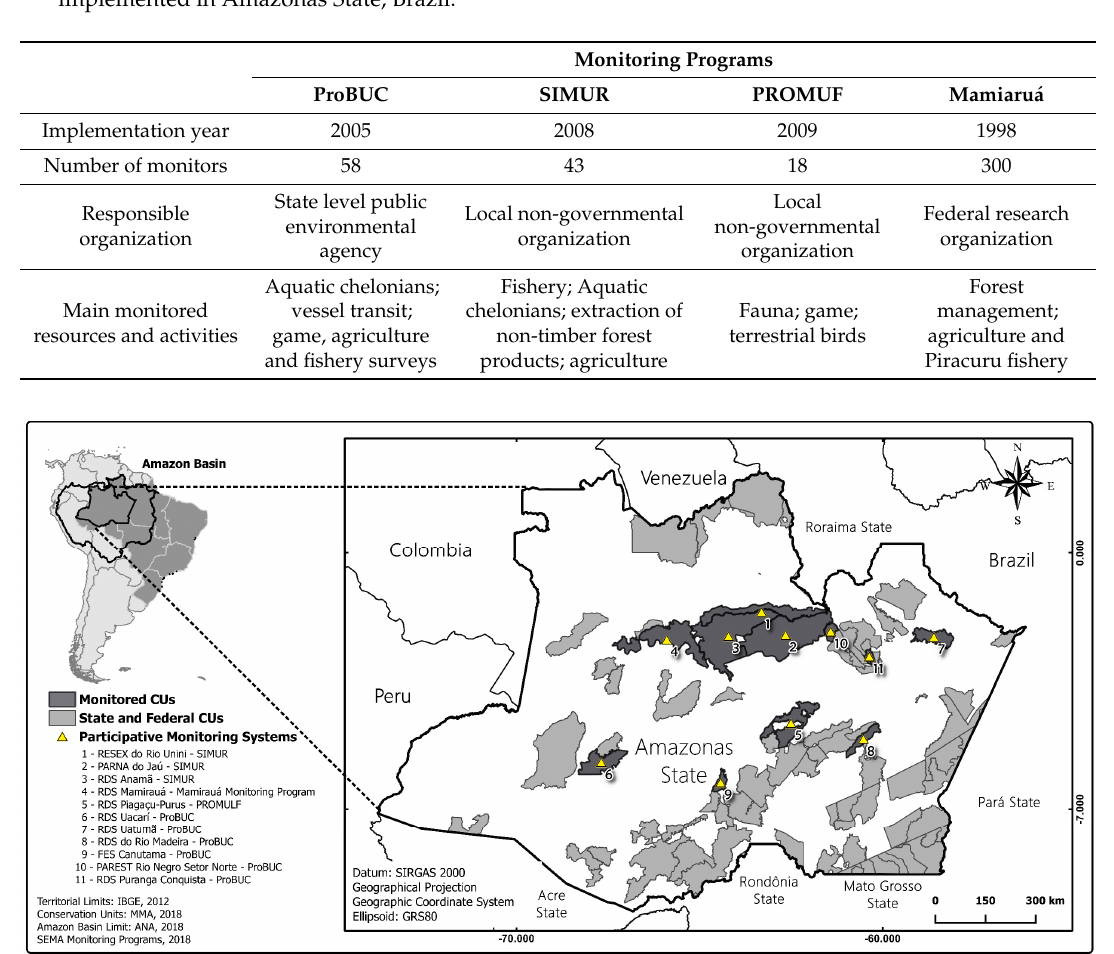
Figure 1. Localization map of the Conservation Units (CUs) of Amazonas State,